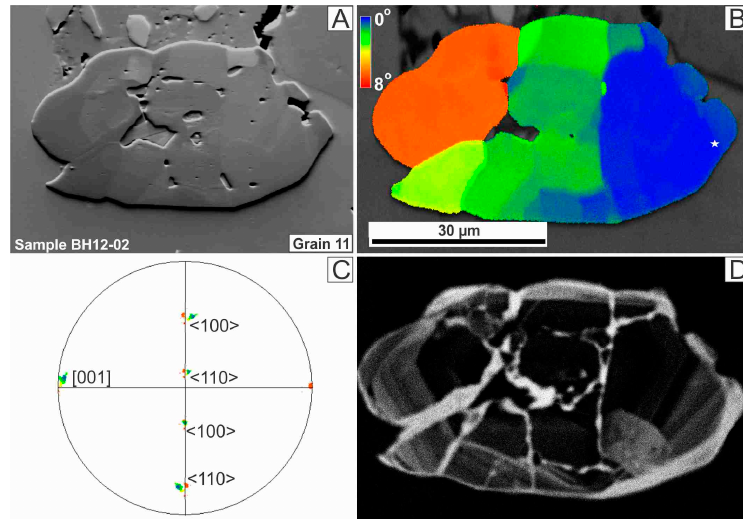
Figure 6. Data on the grain 11, sample BH12-02. ( A ) Orientation contrast image. ( B ) Cumulative misorientation or texture component EBSD map, showing the orientation of every data point with respect to a user-selected reference point (white star). Misorientation varies from 0 (blue) to 8° (red). ( C ) Lower hemisphere equal area projection pole figure, showing unsystematic dispersion of the crystallographic axes [001], <100> and <110>. Color-coding as in the EBSD map in B. ( D ) Panchromatic CL image.